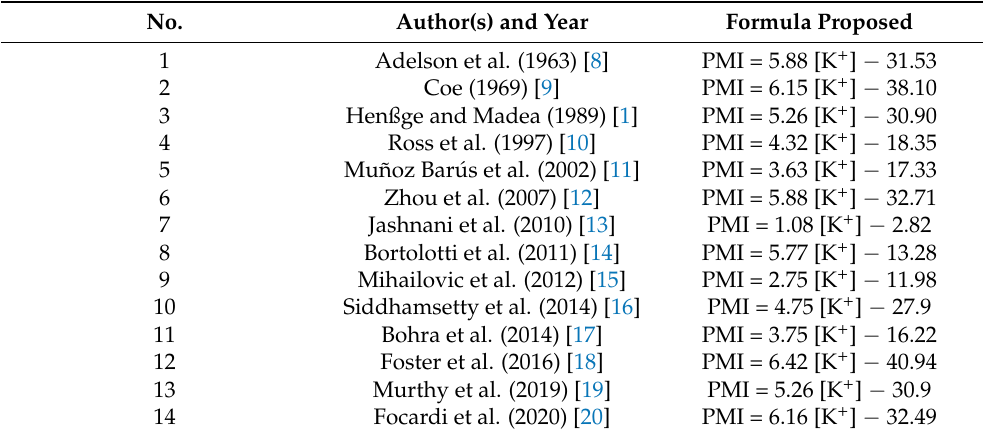
Table 1. Formulas for estimating the PMI based on the concentration of potassium ions ([K + ] in mmol/L).